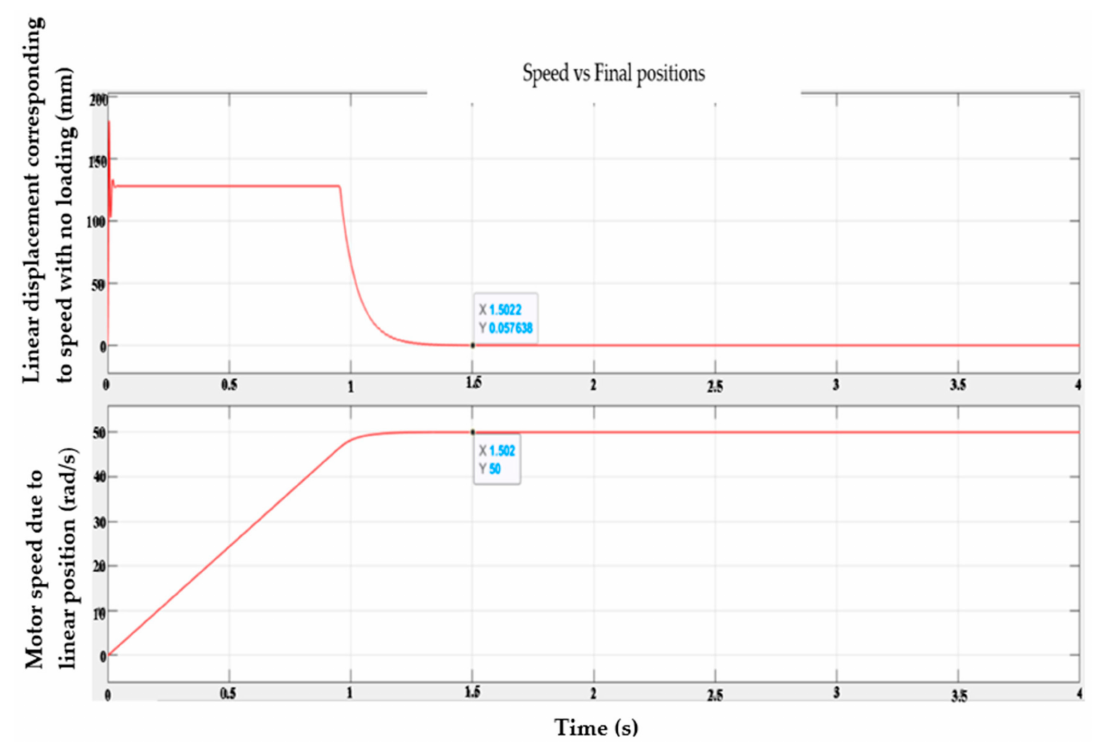
Figure 10. No effect of parameter changes on the demanded speed by the